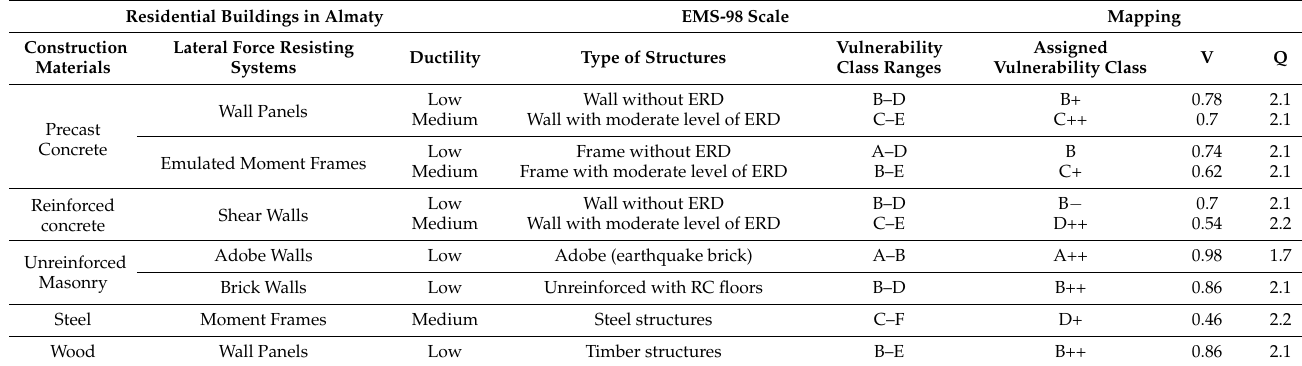
Table 6. Mapping of residential buildings in Almaty to the EMS-98 scale.